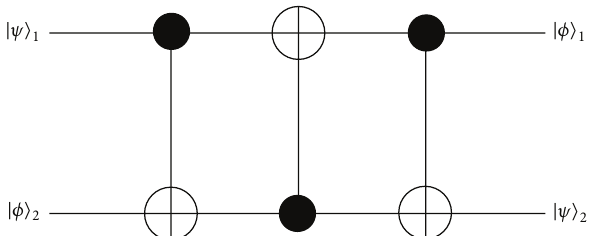
Figure 2: The swap gate cascades three quantum Controlled-Not gates.